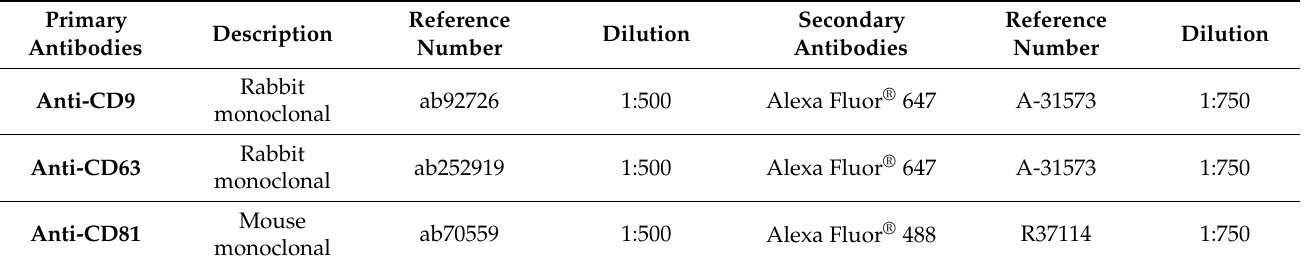
Table 1. Antibodies used for